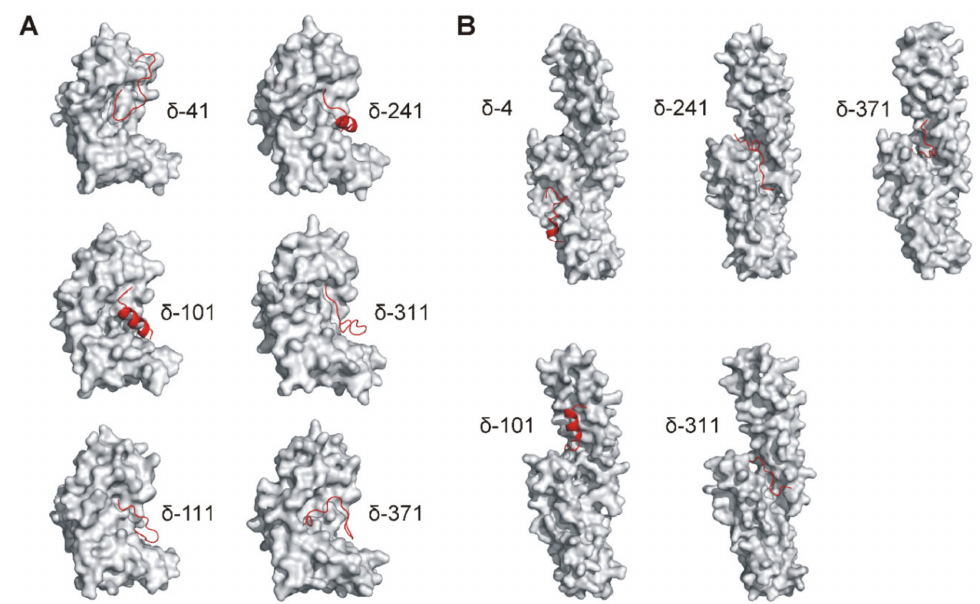
Figure 3. Peptide–protein docking models simulating interactions of CK1 δ -derived peptides with N-APP/E1 and E2 protein domains of APP. CK1 δ -derived peptides previously identified to bind and inhibit phosphorylation of APP695 protein fragments were used for in silico docking experiments using a protein structure encompassing ( A ) the N-APP/E1 domain (4PWQ [25]) or ( B ) the E2 domain of APP (3UMI [26]). Docking simulation was performed by CABS-dock server for flexible protein–peptide docking, and the best-ranked model (according to cluster density) for each docking analysis is displayed. Peptide structures are shown in